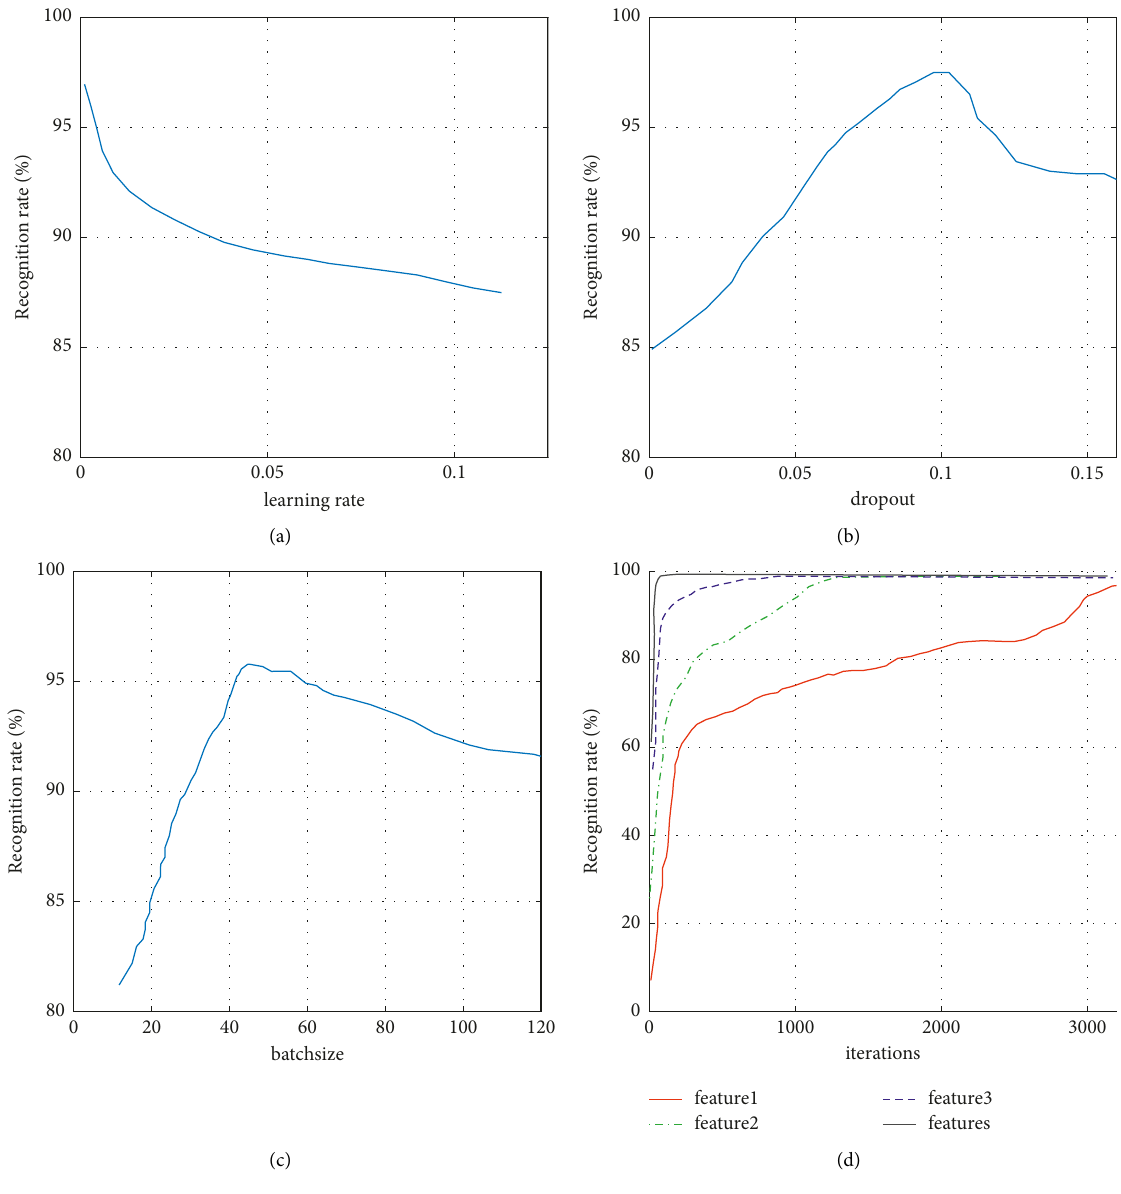
Figure 5: The recognition rate of different